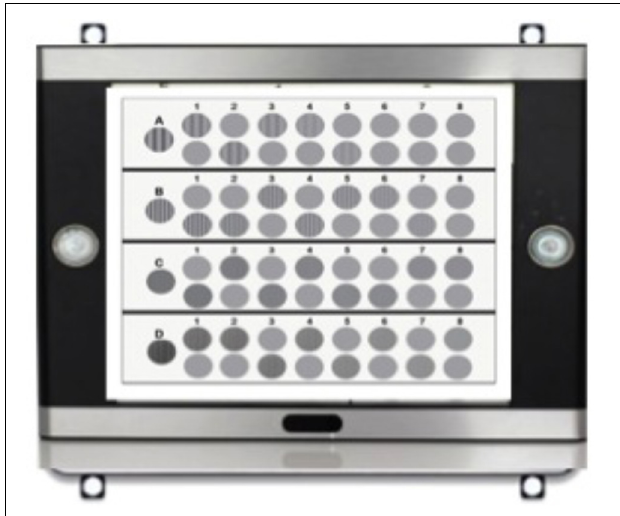
FIGURE 1 | Custom modified CSV-1000E contrast sensitivity test with LED lights placed at each of the four corner of the table and oriented toward the